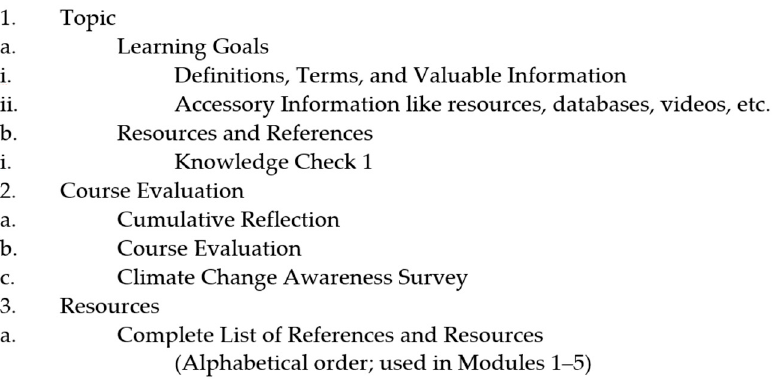
Figure 1. Example outline of a module scene in the course.